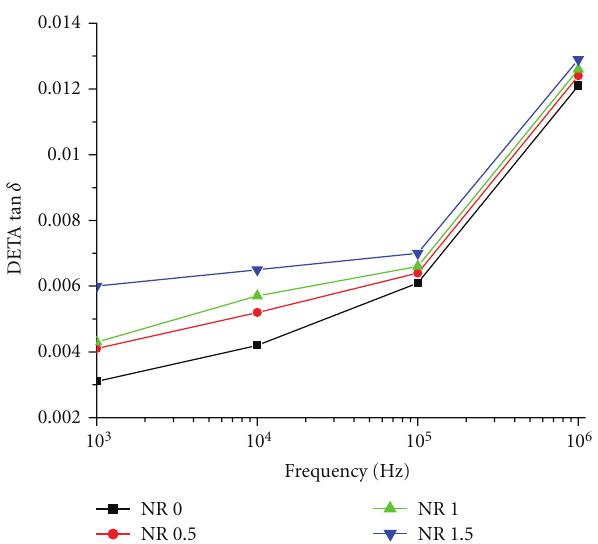
Figure 8: Frequency dependence of DETA tan δ at a di ff erent degree of fullerene filling at 30 ◦ C.